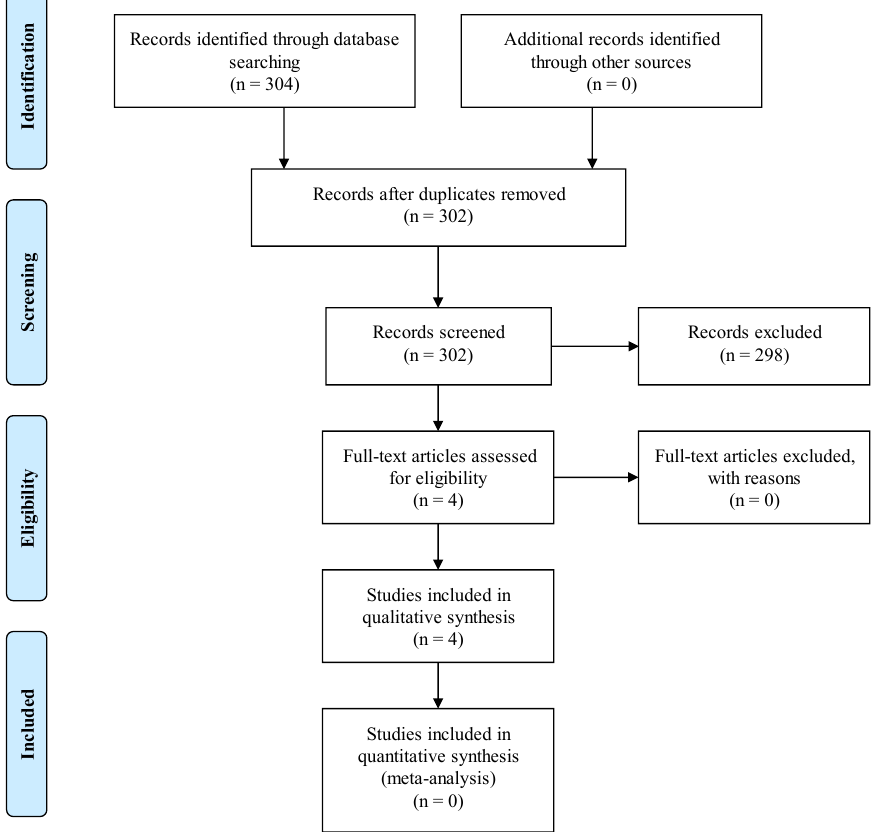
Figure 1. PRISMA flow diagram for the current article process.